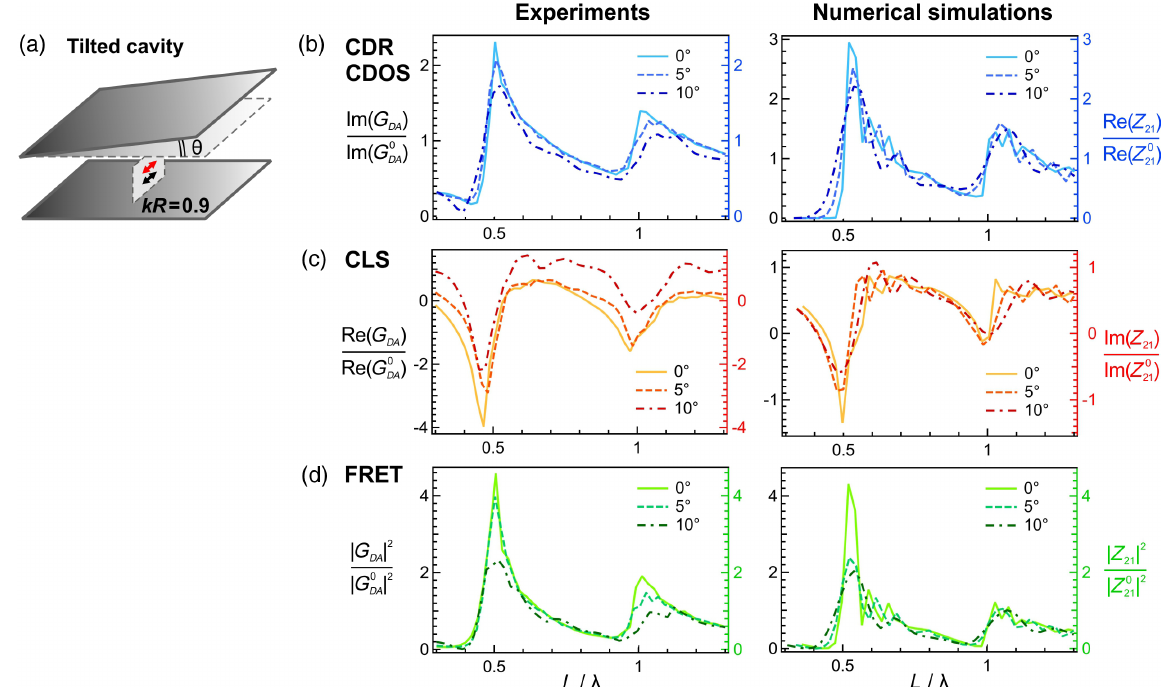
FIG. 3. Effect of a nonplanar cavity on the Green function, corresponding to a case for which no analytic solution exists. (a) One mirror forming the cavity is tilted by an angle θ ; the rest of the configuration is similar to Fig. 2. The distance between the dipoles is kR ¼ 0 . 9 . (b) CDR-CDOS, (c) CLS, and (d) FRET enhancement factors versus the cavity length for different tilt angles θ . The left-hand column shows the experimental results, whereas the right-hand column presents the numerical simulation results using the finite domain time difference method (CST Studio suite